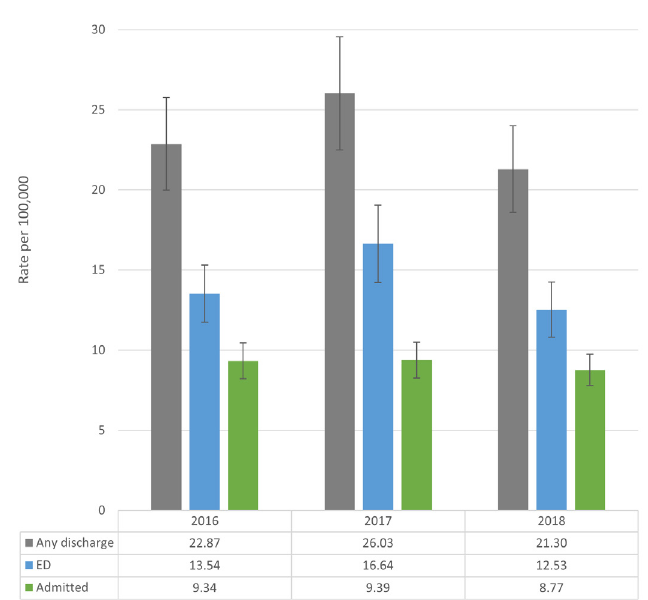
Figure 1. Rate of nonfatal firearm injury episodes in the United States per 100,000 population, by year, 2016-2018. Admitted nonfatal firearm injury episodes from the National Inpatient Sample (2016-18). Emergency department (ED) nonfatal firearm injury episodes from the Nationwide Emergency Department Sample (2016-18). Population from Healthcare Cost and Utilization Project files. Lines represent 95% confidence intervals for weighted survey